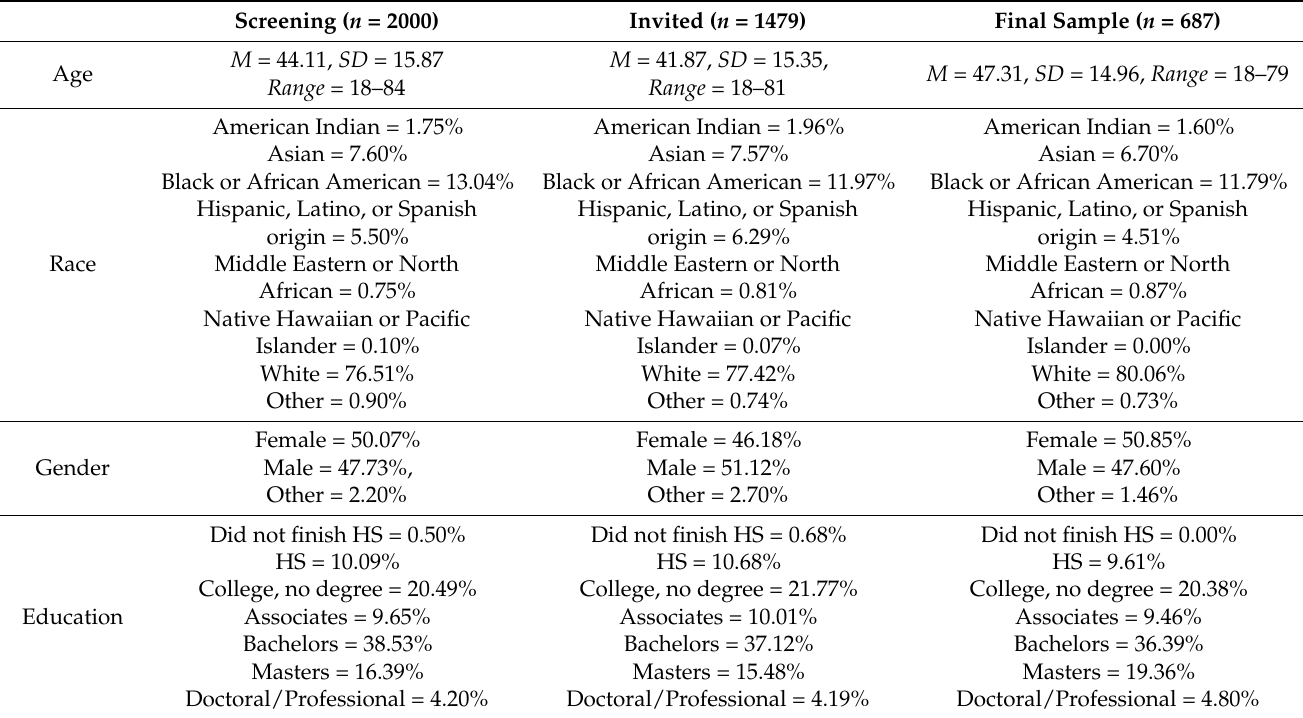
Table 1. Demographic